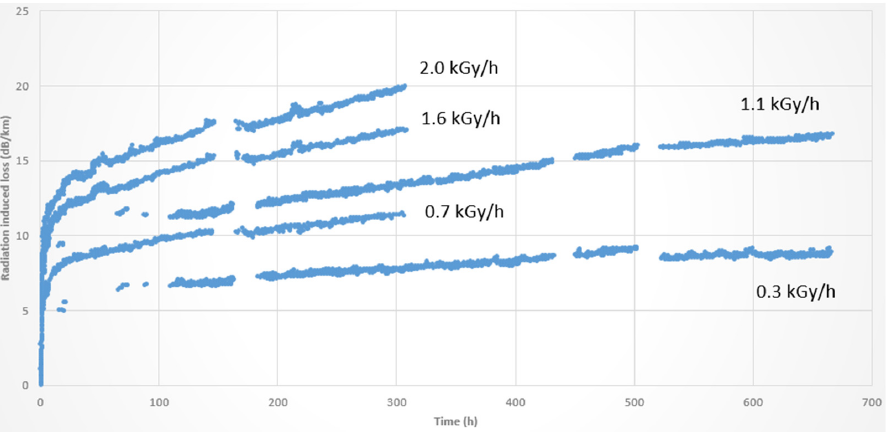
Figure 15. Radiation-induced loss at 850 nm in Spectran TCG MM fiber at different dose rates adapted from [142] fitted according to the power–law model of M. Van Uffelen et al. [143]. Other measurements were made on COTS optical fiber, vertical cavity surface emit- ting laser diodes, LEDs, multimode photodiodes, and WDM components [142]. The opti-